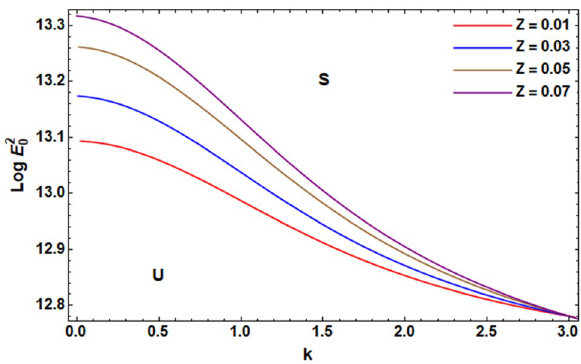
Figure 3. Linear stability profile corresponding to Eq. (51) for the deviation of Z .